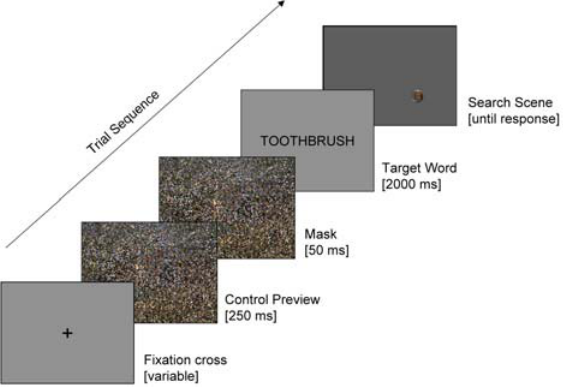
Figure 1. Trial sequence of the target